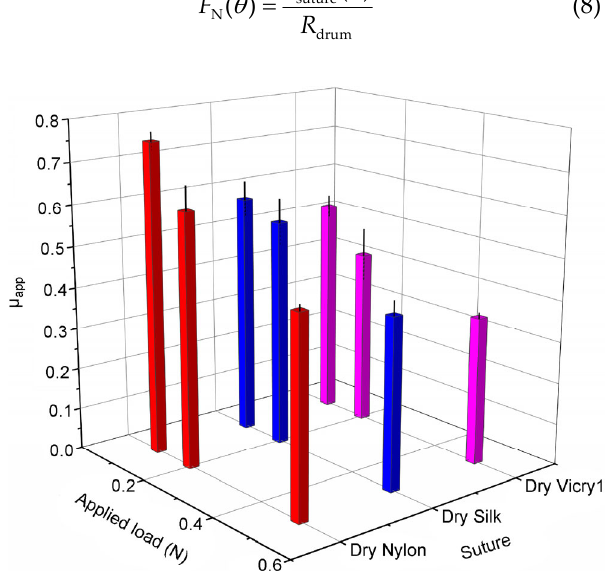
Fig. 6 Apparent coefficient of friction of (a) silk, (b) vicryl, and (c) nylon under different applied load and at 15